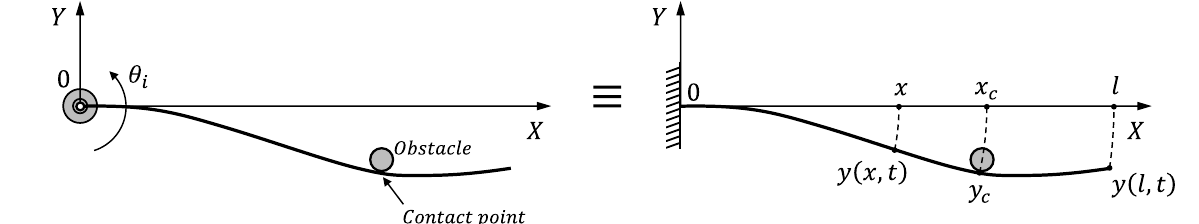
Figure 6. Scheme of the deflection on the bending